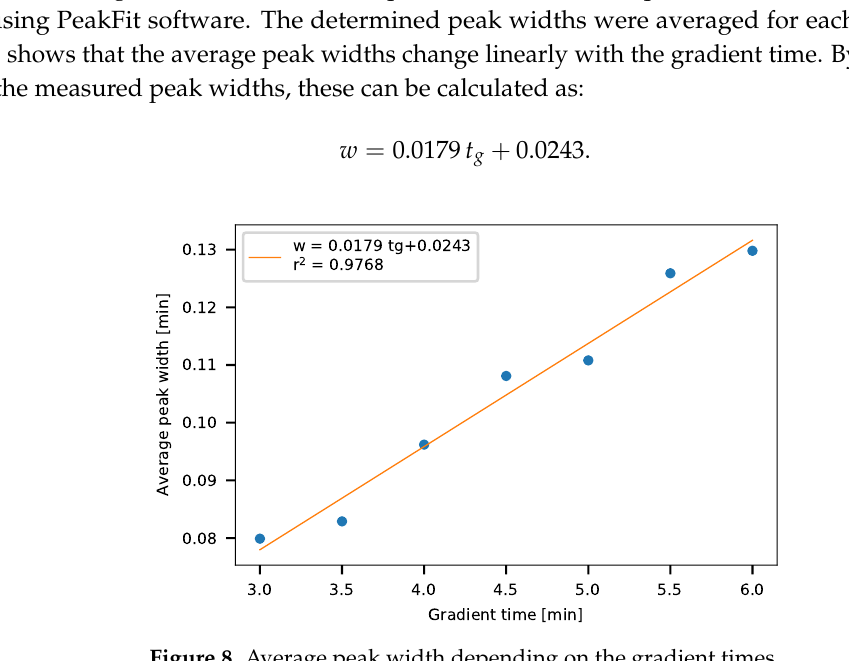
Figure 8. Average peak width depending on the gradient